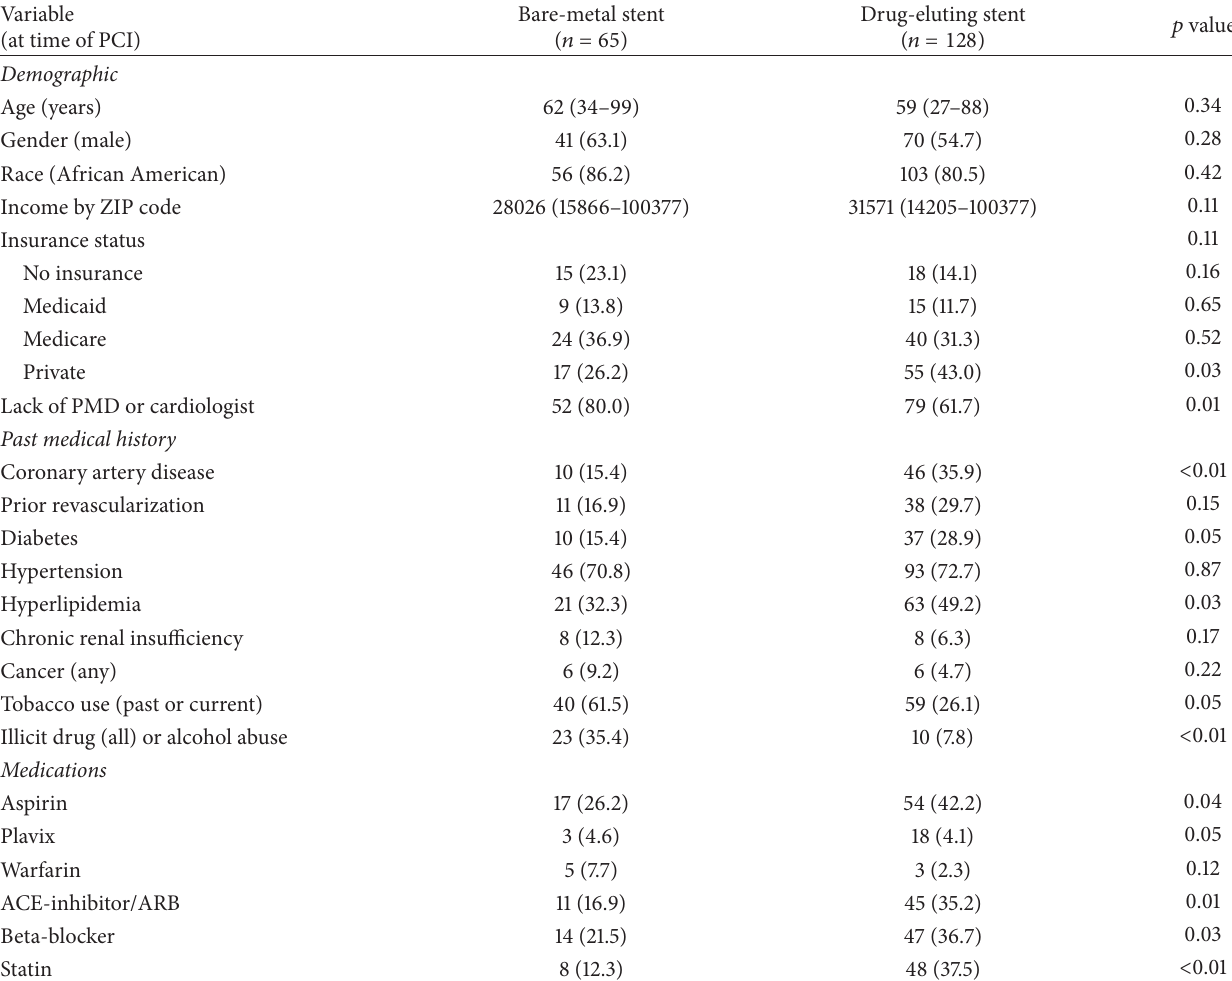
Table 1: Association of clinical variables with DES or BMS use in primary PCI for